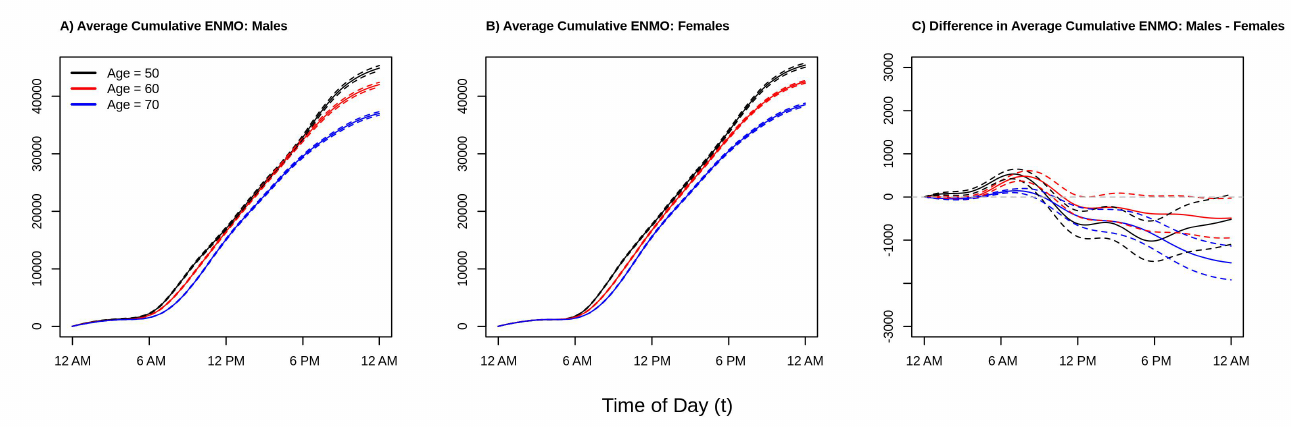
Figure 3. Estimated population cumulative average acceleration (ENMO) by time of day for Males ( panel A ), Females ( panel B ), and the estimated difference between Males and Females ( panel C ). separately for ages 50 (black), 60 (red), and 70 (blue) years old. Solid lines denote point estimates and dashed lines represent point-wise confidence intervals. Estimates of the curves presented in panels A/B are obtained by fitting a function-on-scalar regression (FoSR) model separately by sex where the population average activity count is allowed to vary smoothly in both time of day and age, then numerically integrating the estimated population average activity count over the 12 a.m.–12 a.m. period. The FoSR model is fit by modelling the average ENMO as a tensor product smooth of marginal spline bases, with cyclic cubic regression splines used in the time domain to respect the cyclic nature of time. Panel C is obtained by taking the difference of panels A and